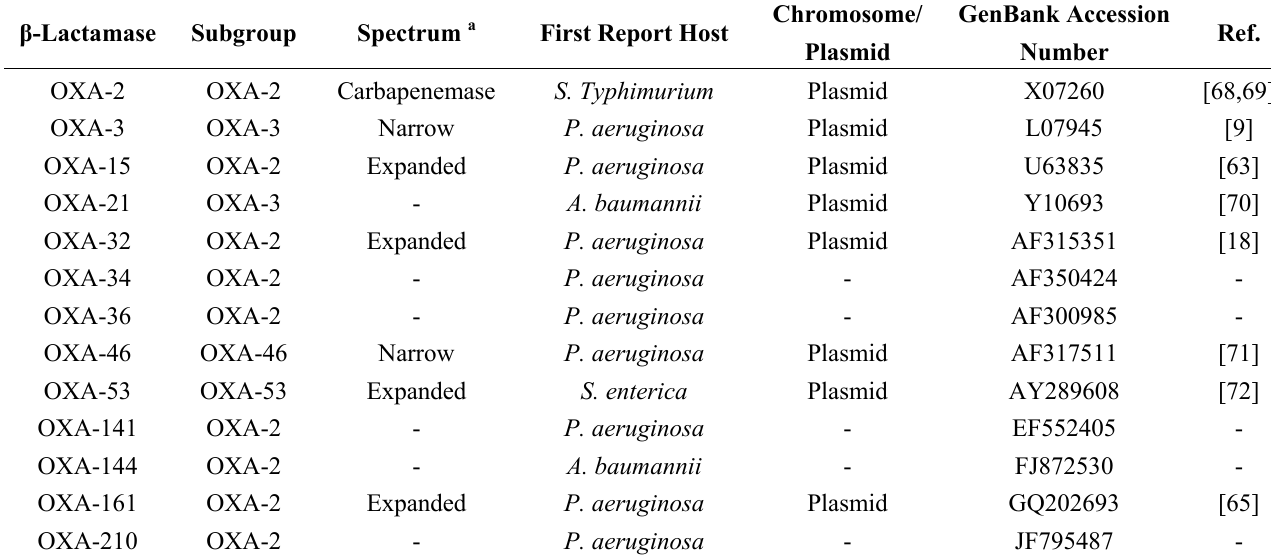
Table 8. OXA-2 like